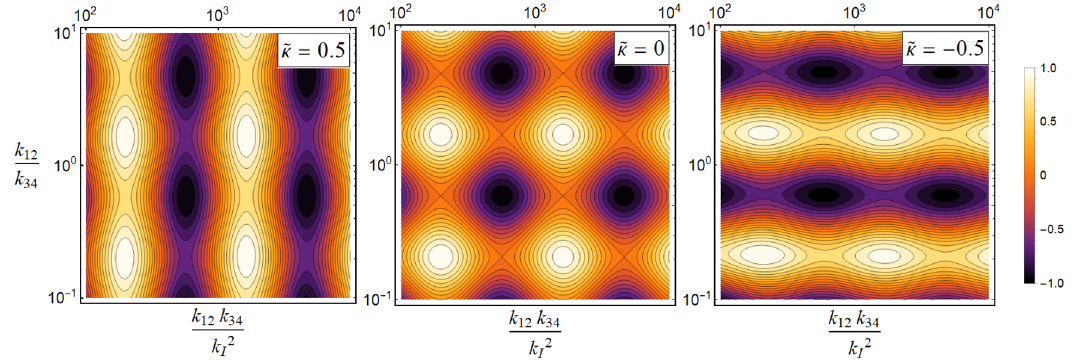
) 9 / 2 S > ( k 12 , k 34 ) | λ = − 1 , for dif- I I